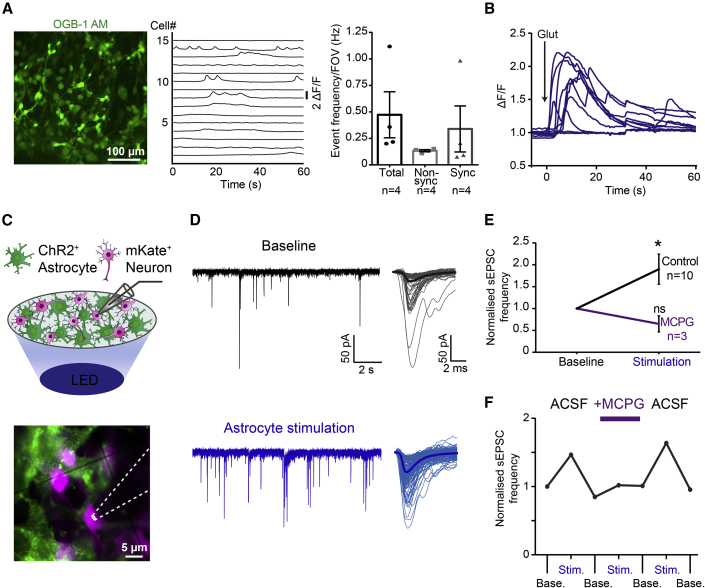
Cortically Derived iPSC-Astrocytes Engage in Ca2+ Signaling and Astrocyte-to-Neuron Gliotransmission(A) Human iPSC-astrocyte culture loaded with OGB-1 AM dye (left; 96 days) and ΔF/F traces from 15 astrocytes in the same culture (middle). Population data on spontaneous Ca2+ event frequency (right) for either all Ca2+ events in a recording (Total), Ca2+ events occurring in individual astrocytes (Non-sync), or Ca2+ events occurring simultaneously across multiple astrocytes (Sync) (n = 4 fields of view [FOV] from four cultures across three cell lines, 101 ± 3.9 days).(B) Time-locked Ca2+ events were elicited by focal delivery of 100 μM glutamate via a patch pipette (n = 10 astrocytes from a 96-day-old culture).(C) Optogenetic experimental design for assessing astrocyte-to-neuron gliotransmission (top). mKate+ iPSC-neurons (magenta) were targeted for recordings (bottom), and co-cultured ChR2+ iPSC-astrocytes (green) were optically stimulated via a blue LED.(D) Example spontaneous excitatory synaptic currents (sEPSCs) recorded from an iPSC-neuron (neurons 60 days at recording, astrocytes 89 days, co-cultured for 20 days) under baseline conditions (top) and during astrocyte stimulation (450 nm LED; 250 ms pulse duration at 2–4 Hz; bottom). An individual trace (left) and overlays of detected sEPSCs (right) are shown, with the average sEPSC in bold.(E) Optical stimulation of astrocytes generates a significant increase in sEPSC frequency under control conditions, which is blocked by the mGluR antagonist, MCPG (0.8 mM). All values normalized to baseline frequency. Sample sizes represent individual neurons recorded from two cultures, one cell line (neurons 58 ± 2 days at recording, astrocytes 103 ± 0.5 days, co-cultured for 21 ± 2.5 days).(F) Individual experiment in which astrocyte stimulation increased neuronal sEPSCs before application of MCPG, and after washout of MCPG, but not in the presence of MCPG. ∗p < 0.05.